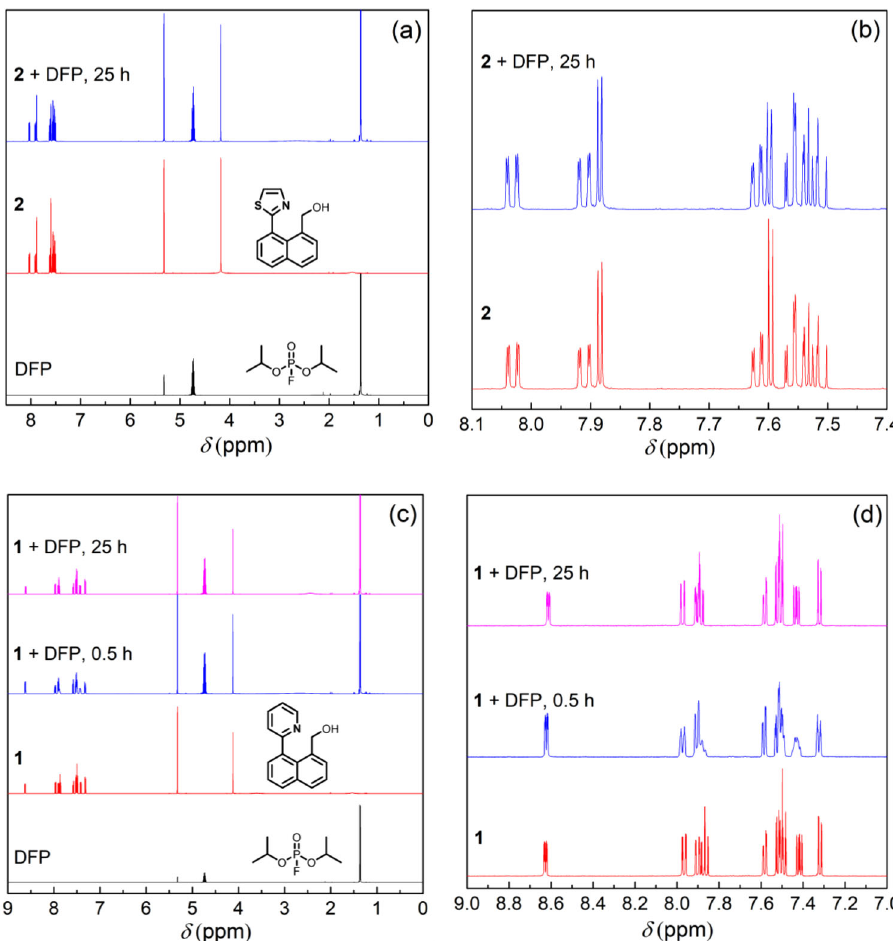
Fig. 4 1 H NMR spectra of the sensing compounds upon addition of DFP. Spectra of 2 ( a full spectrum; b aromatic region) and 1 ( c full spectrum; d aromatic region) with addition of DFP (1 eq) in dichloromethane-d 2 . All experiments were carried out at room